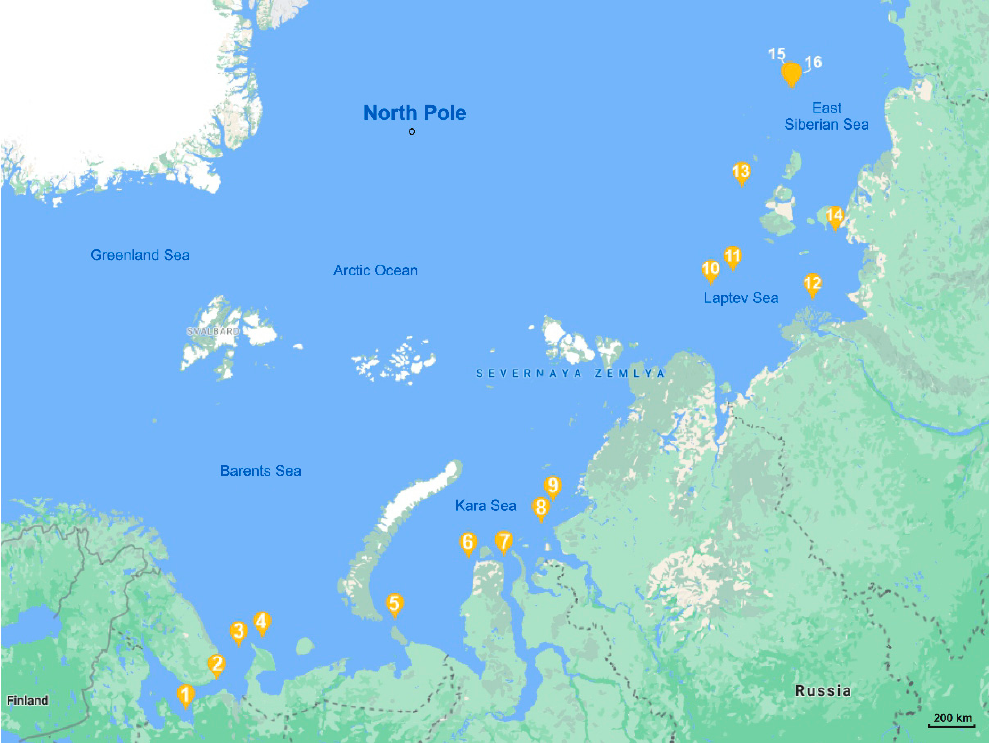
Figure 1. Air s ampling sites during ISSS-2020 expedition. Figure 1. Air sampling sites during ISSS-2020